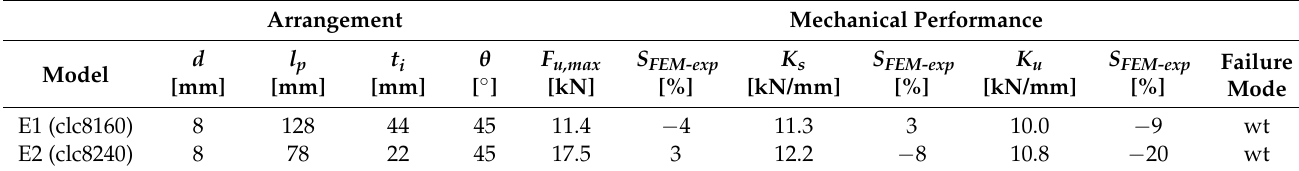
Table 1. Specimen geometric data, FE numerical results per screw and corresponding percentage scatters.